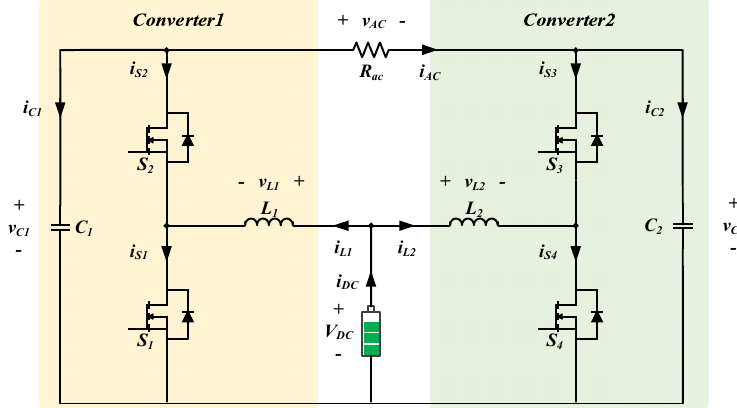
Figure 6. The analytical model of the SSDBI. Table 1. The operation modes of Converter 1 and Converter 2.